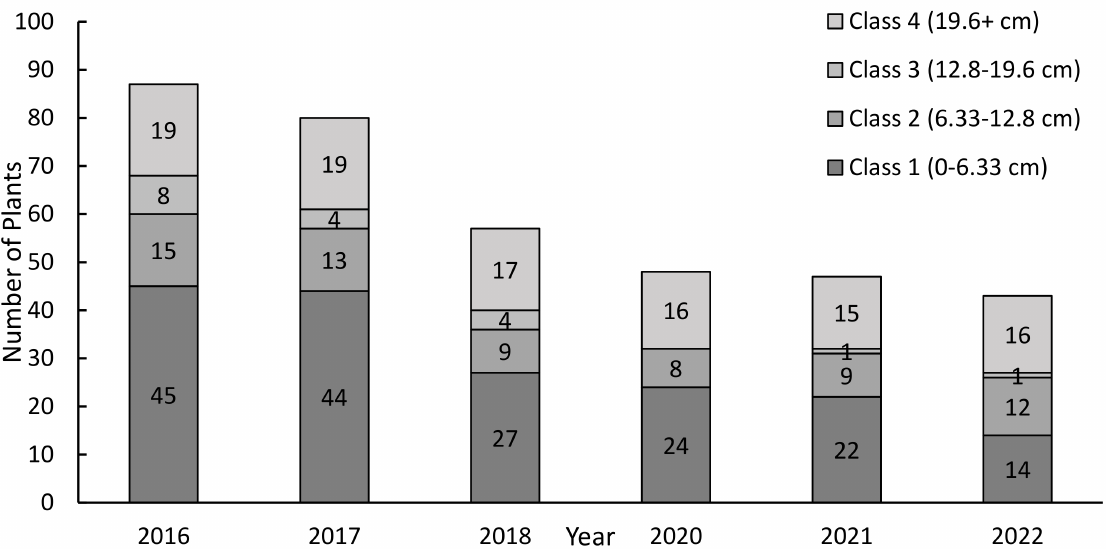
Figure 4. Campylocentrum pachyrrhizum class distributions of the total population at the FPNWR. The class breakdown indicates that there is a large population of Class 1 and Class 4 individuals. There were not many individuals observed in the intermediate (class 2–3) stages.